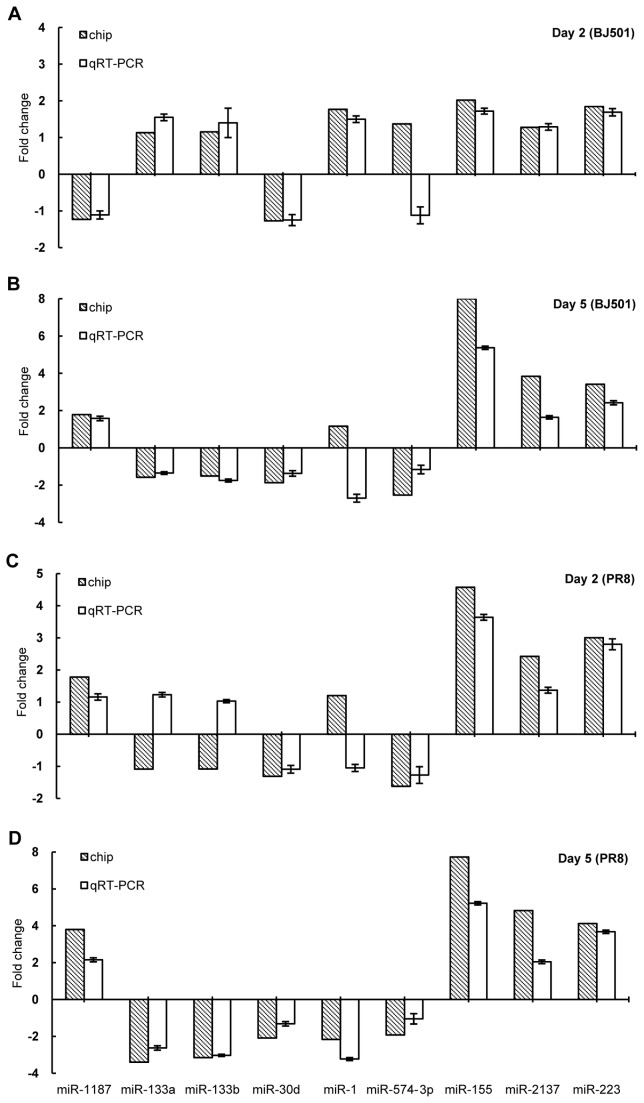
Real-time reverse transcription polymerase chain reaction (RT-PCR) verification of microRNA microarray.Nine differentially expressed microRNAs were selected from microarray datasets and examined by real-time RT-PCR. The fold change of a particular microRNA in the influenza virus BJ501 or PR8 infection relative to the mock infection was calculated. The fold-change from the real-time RT-PCR was determined using the 2-△△Ct method and all microRNA expression values were normalized against the U6 endogenous control. Data from real-time RT-PCR are shown as mean ± standard deviation (SD).